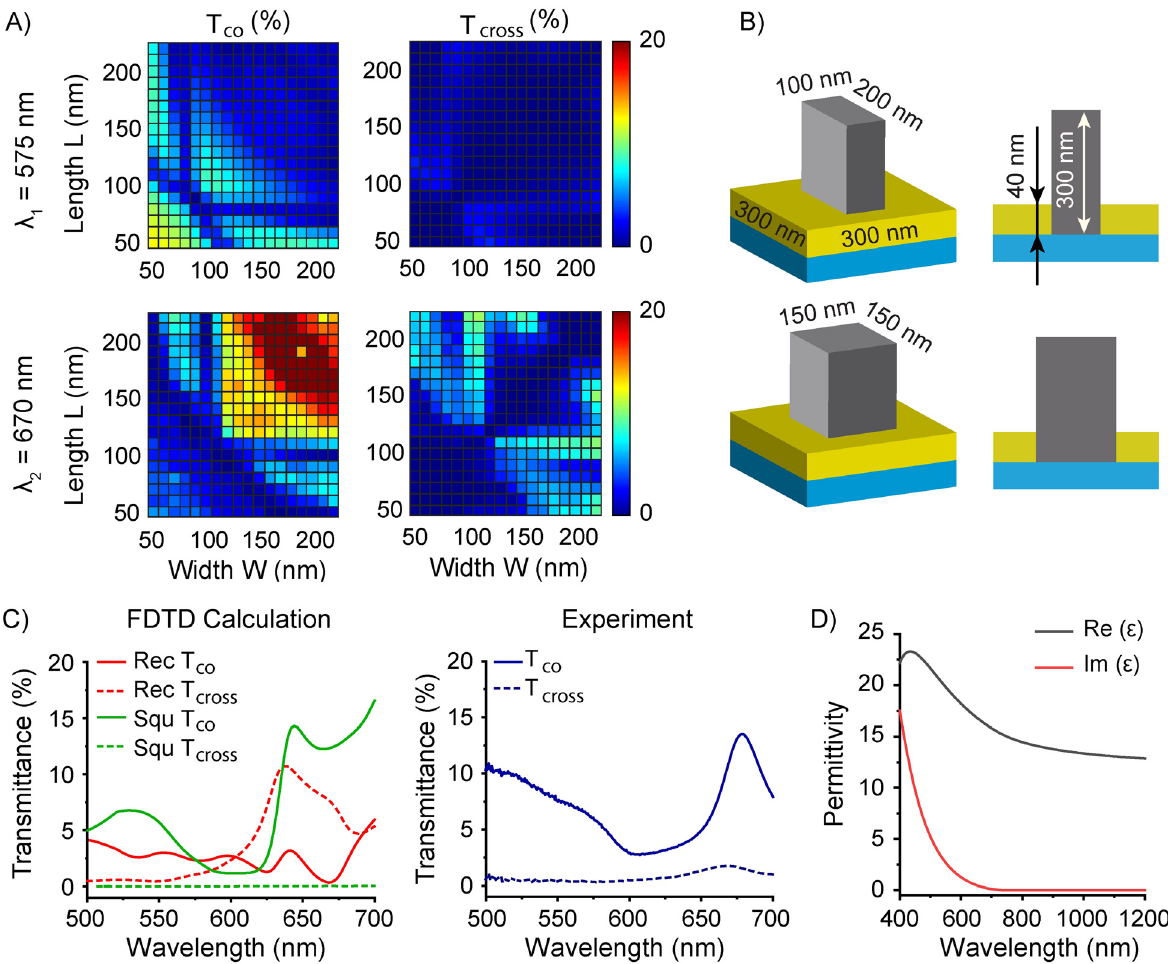
Figure 3: Simulated and experimentally measured transmittance. (A)Parametersweeptoobtaintheoptimizedsiliconantennadimensions L and W forasetheightof300nm.Thetransmittanceiscalculatedin the co- and cross-polarization channelsat the design wavelengths λ 1 and λ 2 . (B) Selectedantenna dimensionsfor the rectangular and square nanoantennas illustrated in 3D and the corresponding 2D cross-sections. (C) Left: calculated transmittance of the selected silicon antennas (Rec:100 × 200 × 300nm;Squ:150 × 150 × 300nm)includingthegold fi lmintheco-andcross-polarizationchannelwith fi nite-differencetime- domain method (FDTD). Right: measured transmittance of the fabricated modi fi ed photon sieve in the aperiodic arrangement for both polarization channels. (D) Measured permittivity of amorphous silicon used for the